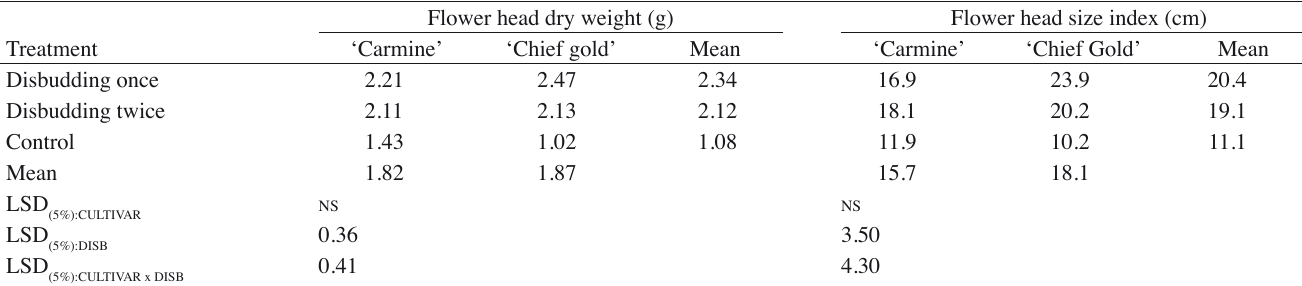
Table 3 - Effects of disbudding on flower head dry weight and size of two celosia varieties at harvest. Experiment 2 Flower head dry weight Treatment